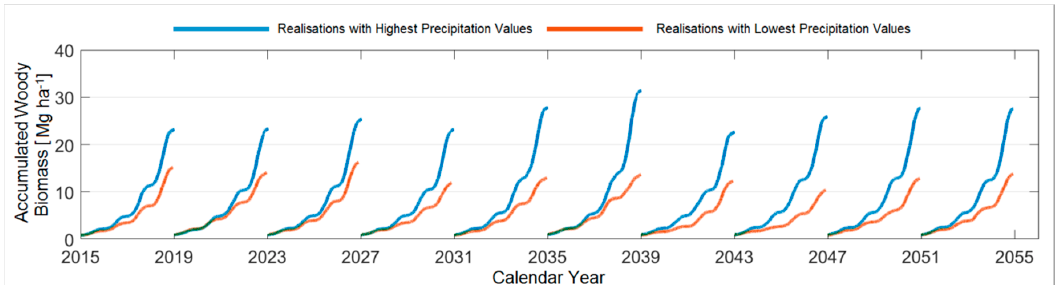
Figure 5. Projected woody biomass of poplar trees under special realisations describing either the highest precipitation values (blue) or the lowest precipitation values (orange) with respect to the ten established growing periods.